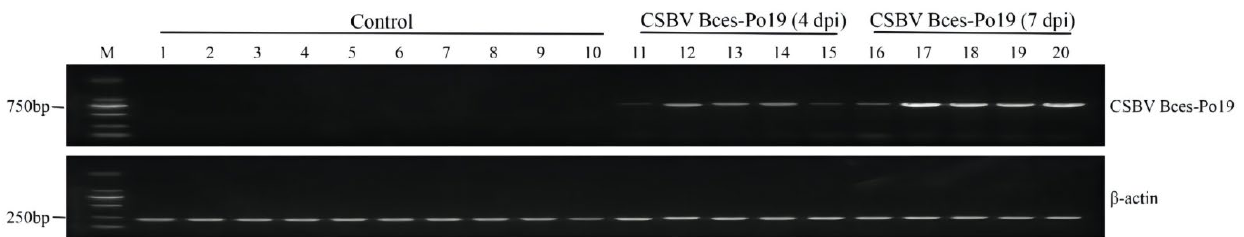
Figure 4. RT-PCR detection of CSBV Bces-Po19 in JFB cells. M, DL2000 DNA marker; Lanes 1–5, control JFB cells cultured for 4 days; Lanes 6–10, control JFB cells cultured for 7 days; Lanes 11–15, CSBV Bces-Po19-infected JFB cells for 4 days; Lanes 16–20, CSBV Bces-Po19-infected JFB cells for 7